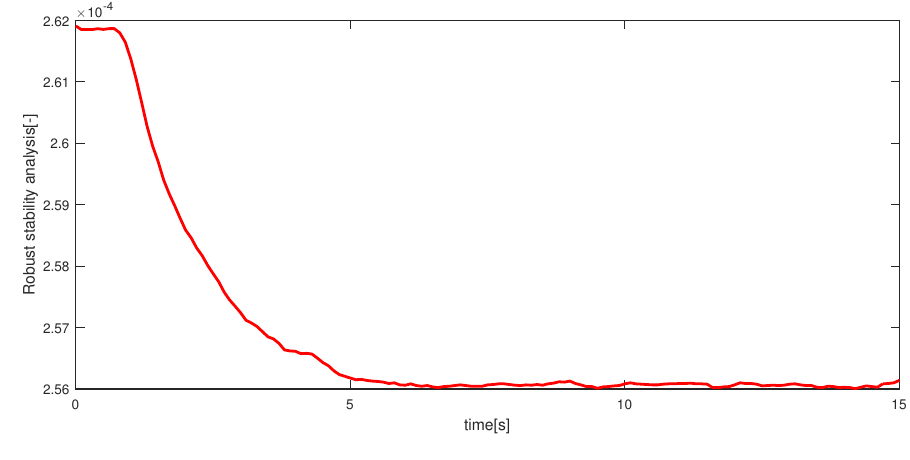
Figure 18. Robust stability